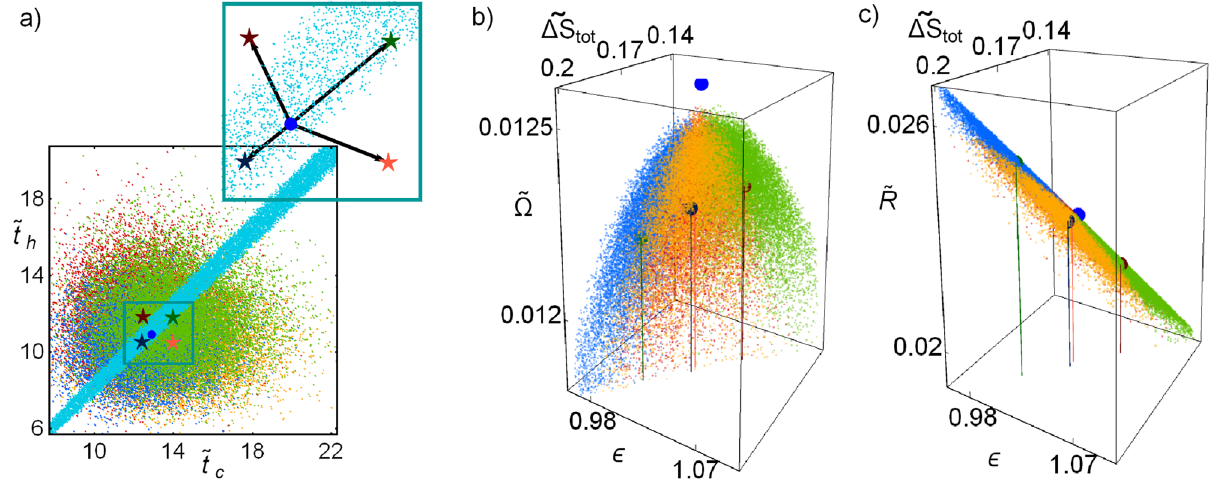
10 4 trajectories. In the inset box a close caption of the geometric centers Figure 10. ( a ) Ending points of 5 × of all the trajectories in each quadrant is displayed. Starts denote the geometric centers of the points in each (cid:31) , and ( c ) averaged values of (cid:31) S , ε and quadrant according to Fig. 9b; ( b ) Averaged values of (cid:31) S , ε and 1 are used, but for other values the behavior is 3 / 5 and (cid:31) representative values τ = = (cid:31)